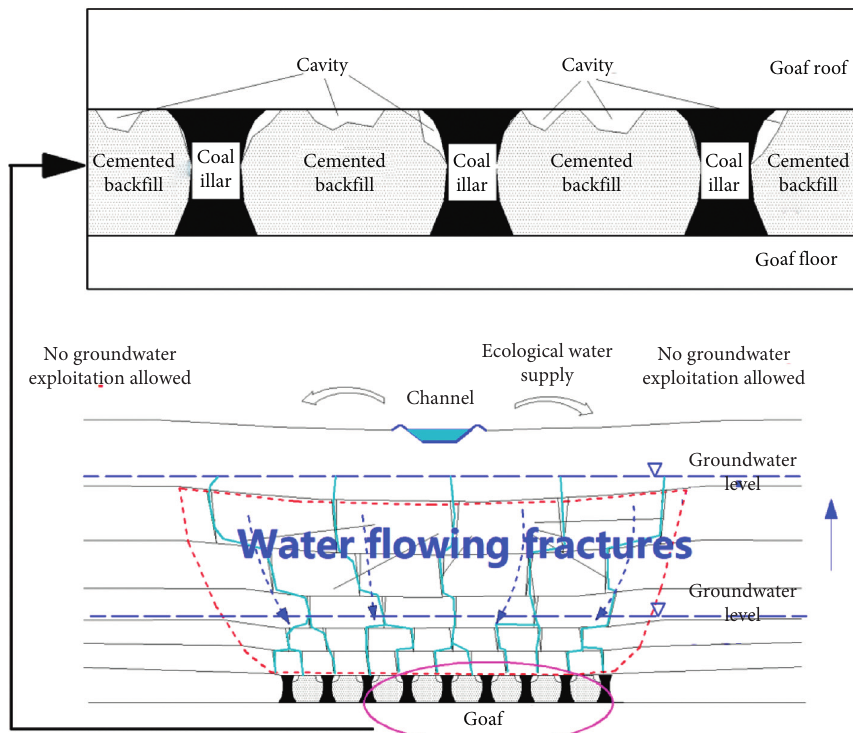
Figure 4: Change in the goaf groundwater environment and inadequate goaf roof-backfill